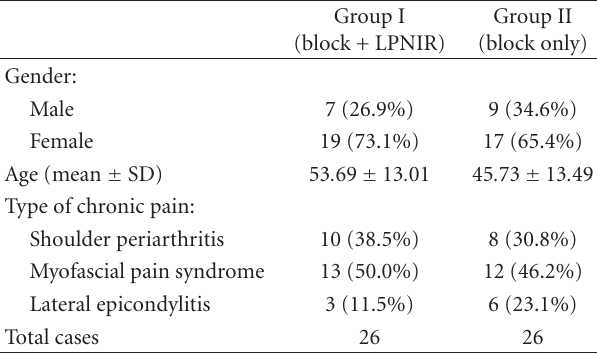
Table 1: Demographics of enrolled subjects in the two